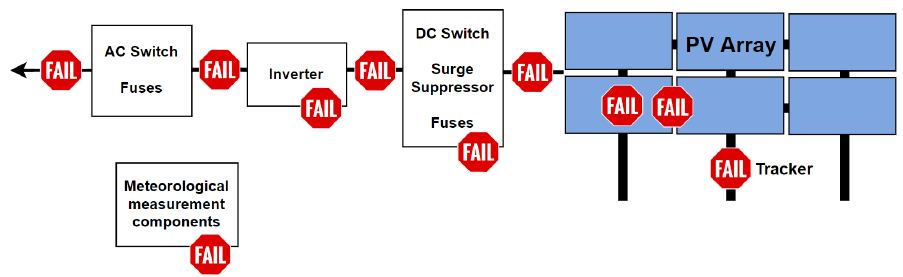
Figure 1. PV plant block diagram displaying potential failure